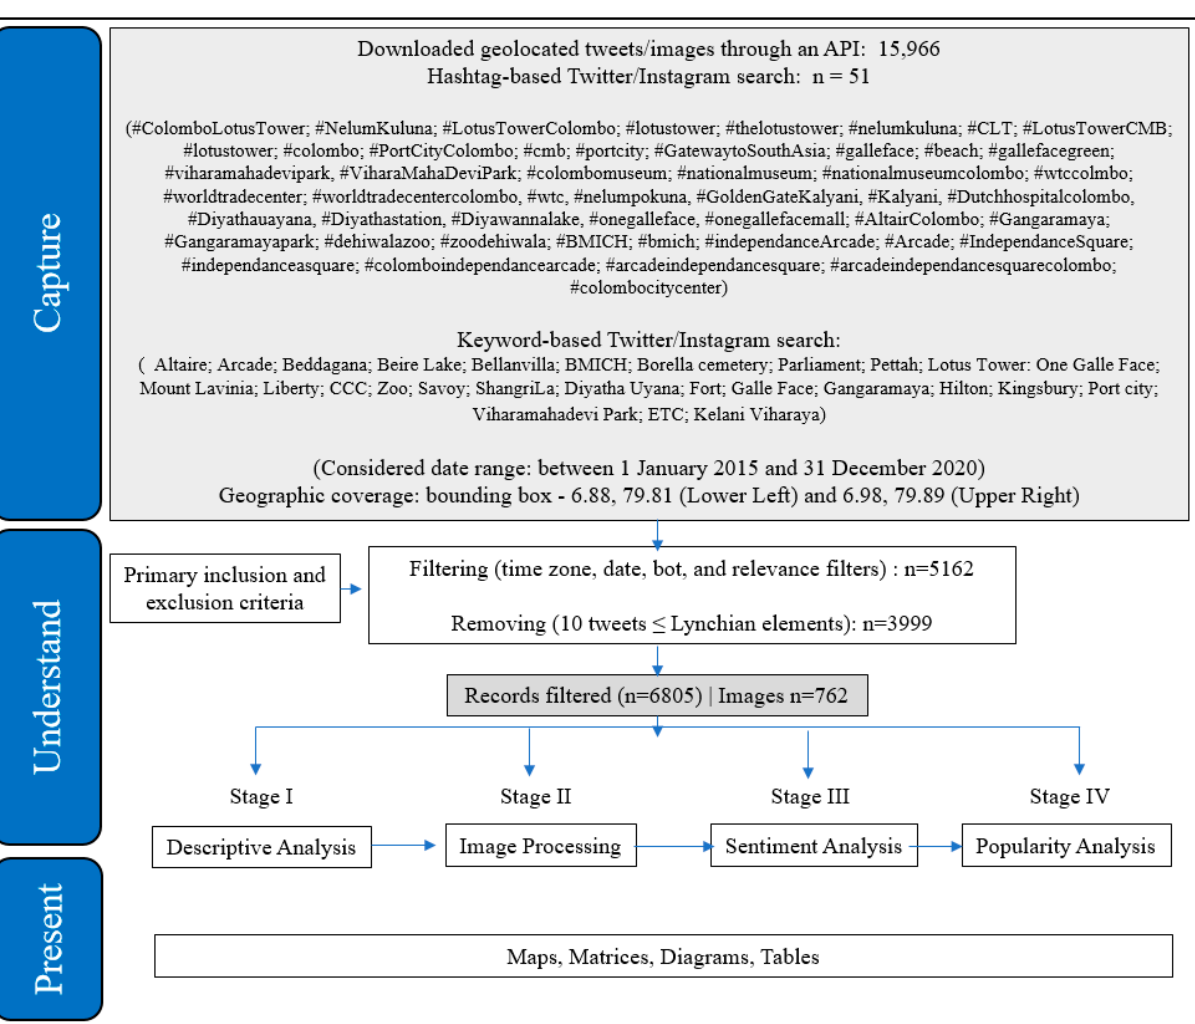
Figure 2. The CUP framework.